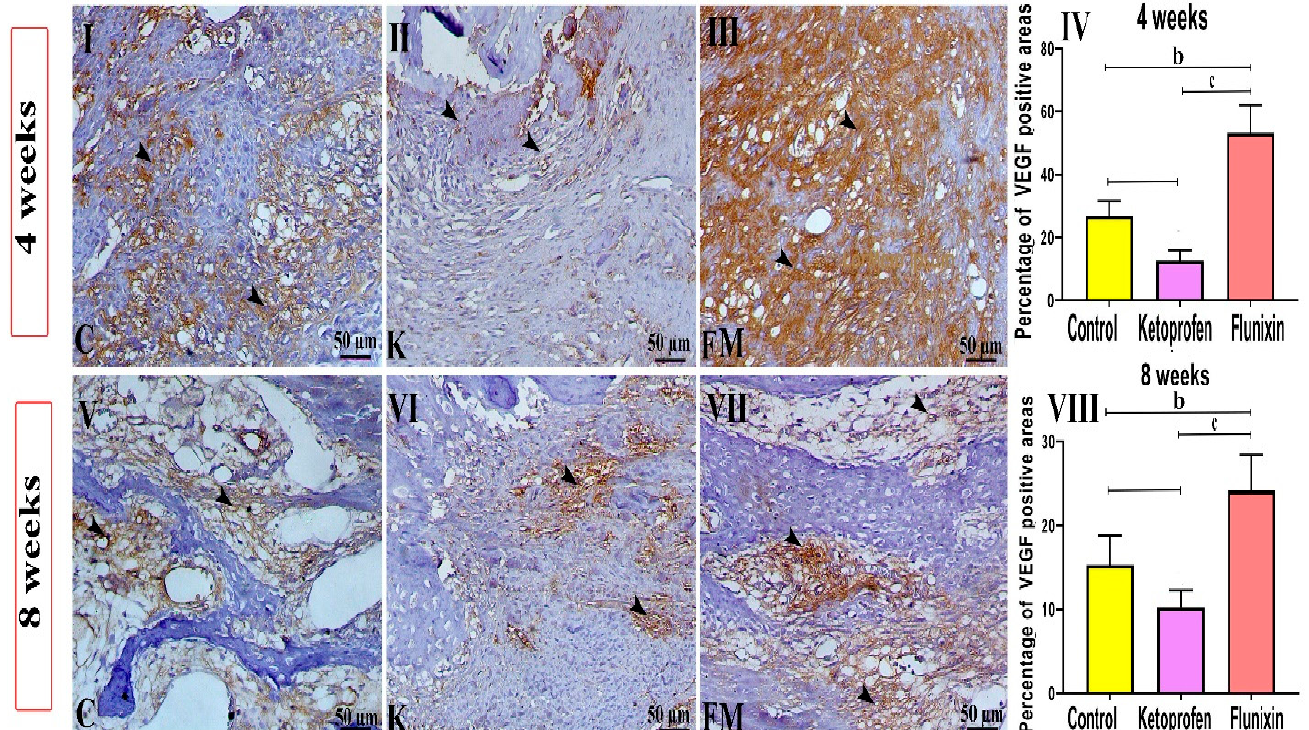
Figure 8. Photomicrographs of different VEGF IHC-stained tibial sections of different groups. C indicates the control group, K indicates the ketoprofen group, and FM indicates the flunixin meglumine group. Ketoprofen-treated animals showed a marked decrease in the expression of VEGF antibody, and FM-treated animals showed marked VEGF immunostaining (arrowheads indicate positive expression). Bar = 50 µ m. Data are expressed as mean ± SD. Superscript letters indicate the significance level; b denotes the significant difference between the FM and control groups. c: denotes the significant difference between the FM and the ketoprofen groups. ( p < 0.05) ( I , V ) denote control group at 4, and 8 weeks. ( II , VI ) denote control group at 4, and 8 weeks. ( III , VII ) denote control group at 4, and 8 weeks. ( IV ) denotes statistical graph to the percent of trichrome staining at 4 weeks between control, ketoprofen, and FM groups. ( VIII ) denotes statistical graph to the percent of trichrome staining at 8 weeks between control, ketoprofen, and FM groups.